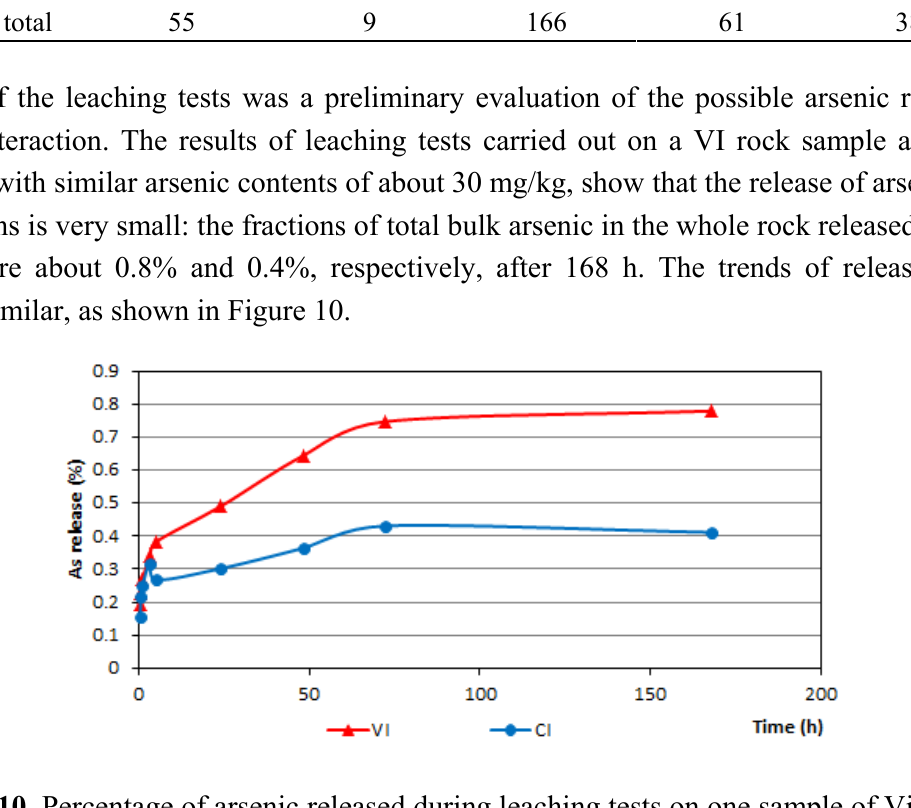
Figure 10. Percentage of arsenic released during leaching tests on one sample of Vico (VI) and one sample of Cimino (CI) rocks (initial arsenic content of both rock samples is about 30